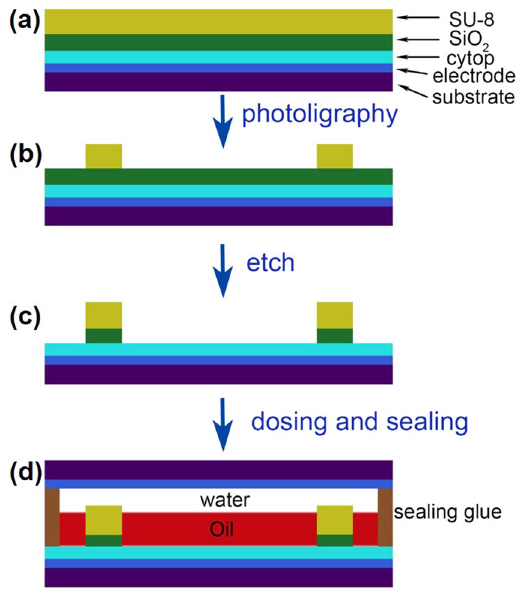
Figure 1. Process flow of the sacrificial layer photolithography strategy on highly hydrophobic substrate ( a – c ), and schematic structure of the EWD ( d